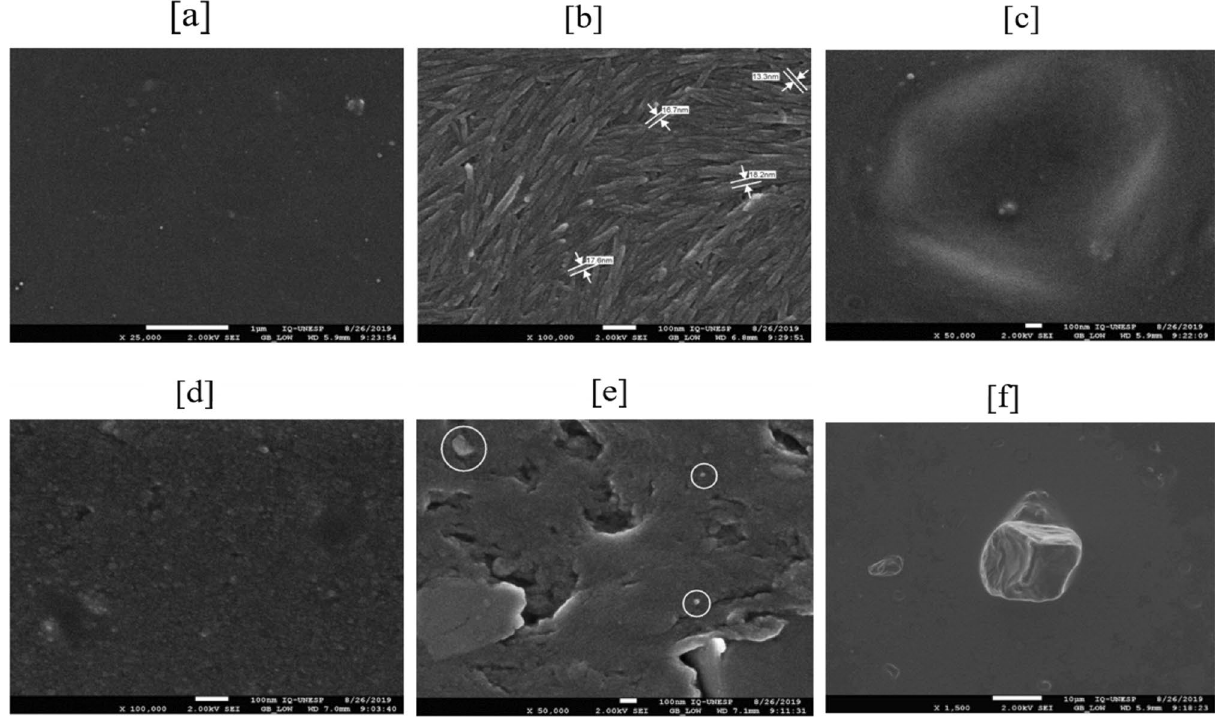
Figure 4. Scanning electron microscopy (FEG-SEM) images of ( a ) the control membrane-100,000 ×, ( b ) the suspension of crystalline nanocellulose—100,000 ×, ( c ) micelles in nanovit membrane—50,000 ×, ( d ) the membrane with addition of vitamin D3—25000x, ( e ) the membrane after release in solution—50,000 ×, and ( f ) micelles and crystals of vitamin D3—1500